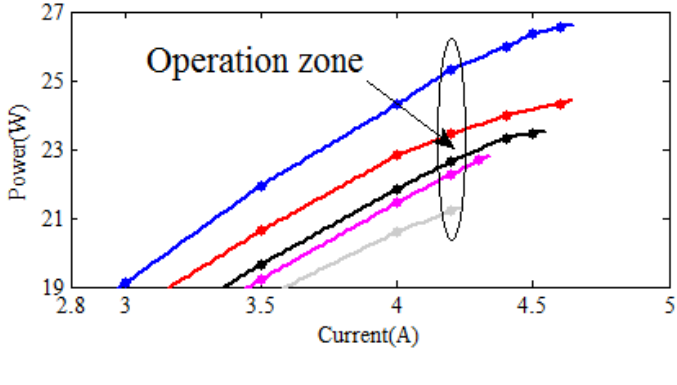
Figure 10. Fuel cell operation